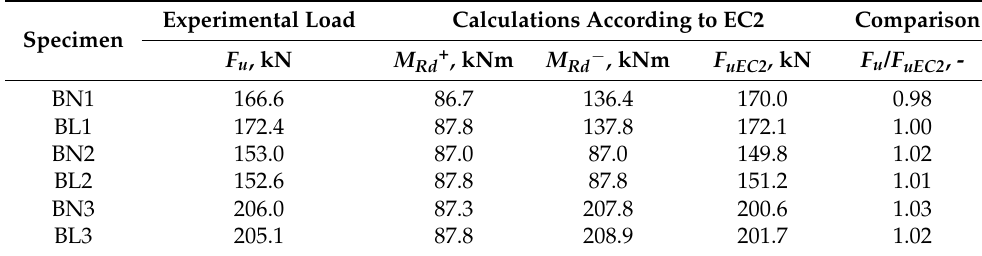
Table 8. Load-bearing